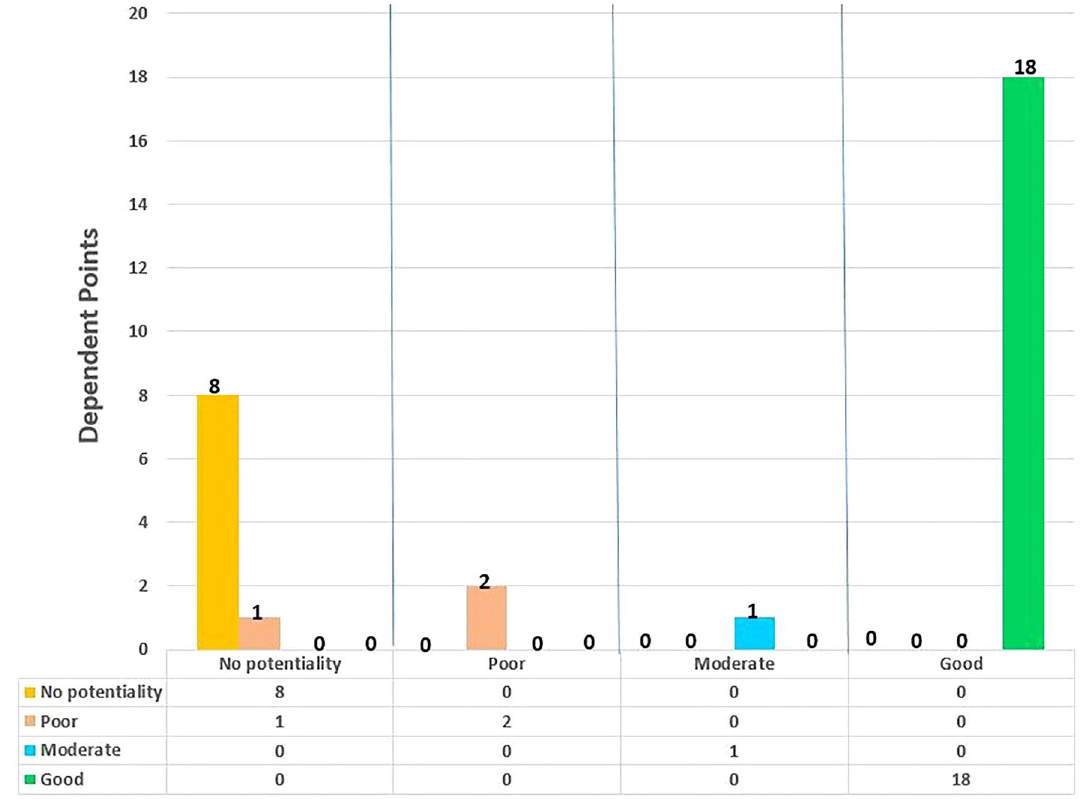
Fig. 9 Groundwater classes with respect to dependent points occurrence potential zones